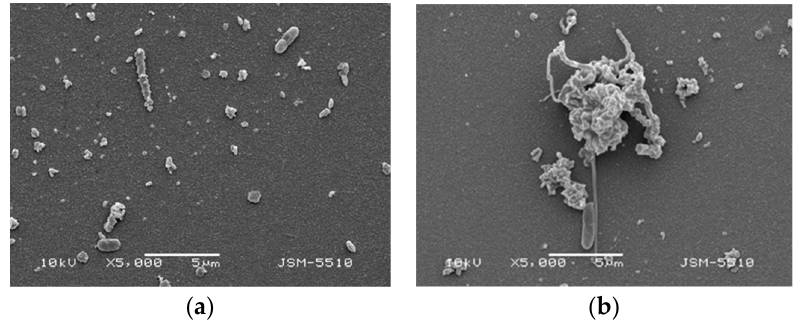
Figure 6. SEM images of significantly damaged E. coli cells ( a ) and E. coli cell aggregates ( b ) in contact with TiO 2 /Ag 23.1 at.% /Cu 21.6 at.% magnetron cosputtered composite coating. Normally, the E. coli cells look like ovals with size of 0.8–1 μ m. They seem to be damaged on the TiO 2 /Ag/Cu coated samples: deformed, with elongated original shape, dehydrated surface and multiple indentations (Figure 6a,b). Large colonies of damaged E. coli cells are also observed in some places (Figure 6b). This could be due to a poured cell content, the last one not seen in these pictures, because it was eluted after the samples had been washed in distilled water. The SEM observation of the E. coli cells on the coated samples demonstrates their contact killing. 4. Discussion The surfaces of all TiO 2 /Ag/Cu coated samples (Samples 1–5) are characterized by similar morphology: Ag/Cu chainlike aggregates distributed chaotically in the coating